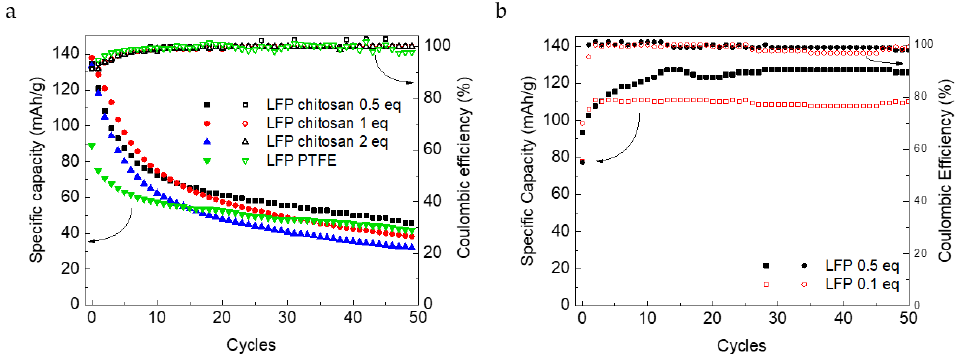
Figure 8 . ( a ) CV curves of different LFP electrodes at 0.5 mV/s in 1M Li 2 SO 4 aqueous solution and Figure 8. ( a ) CV curves of different LFP electrodes at 0.5 mV/s in 1 M Li 2 SO 4 aqueous solution and ( b ) SEM images of pristine and cycled LFP electrodes . ( b , c ) SEM images of pristine and cycled LFP electrodes.